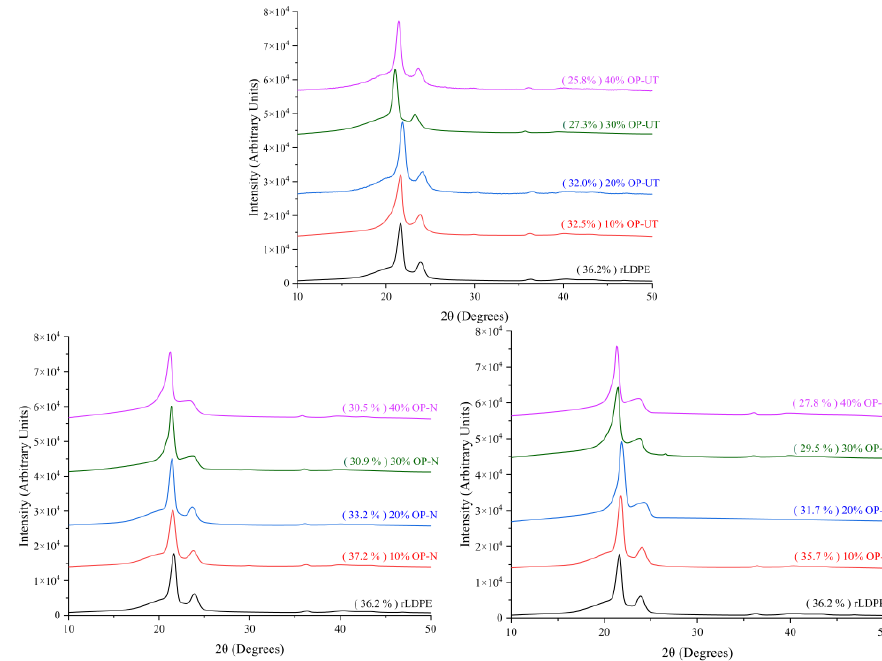
Figure 7. XRD patterns of the developed biocomposites in comparison to neat rLDPE.